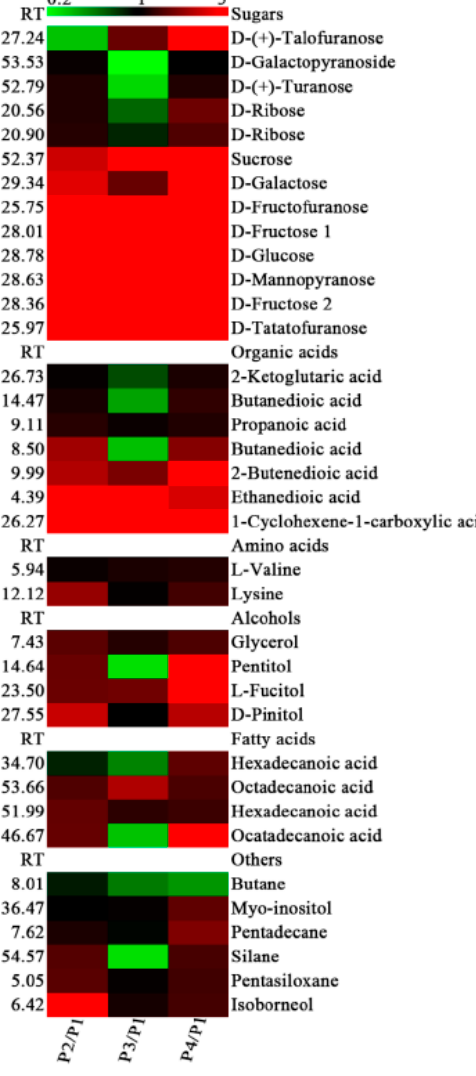
Figure 5. Differentially accumulated primary metabolites in the peel of banana fruit at different stages Figure 5. Di ff erentially accumulated primary metabolites in the peel of banana fruit at di ff erent stages of ripening. The ratios of P2/P1, P3/P1, and P4/P1 are shown. The red squares and the green squares of ripening. The ratios of P2 / P1, P3 / P1, and P4 / P1 are shown. The red squares and the green squares indicate up-regulation and down-regulation of metabolites, respectively. indicate up-regulation and down-regulation of metabolites,